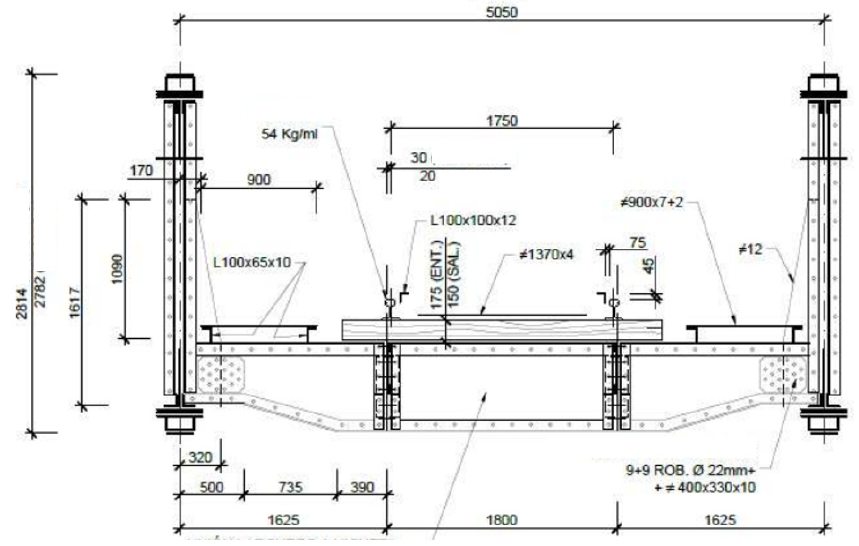
Figure 5. “Bembézar” transversal sketch (Dimensions in mm). The uprights and diagonals are formed by the juxtaposition of angles, with more powerful sections as they approach the